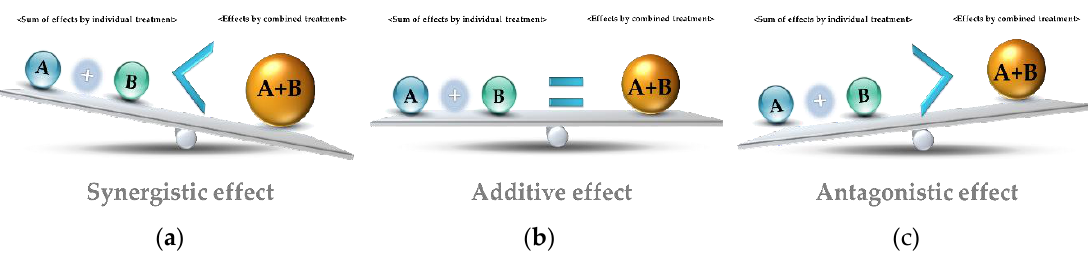
Figure 1. Combined effects of antibacterial complex composed with multiple antimicrobial agents: synergistic effect ( a ); additive effect ( b ); antagonistic effect ( c ).